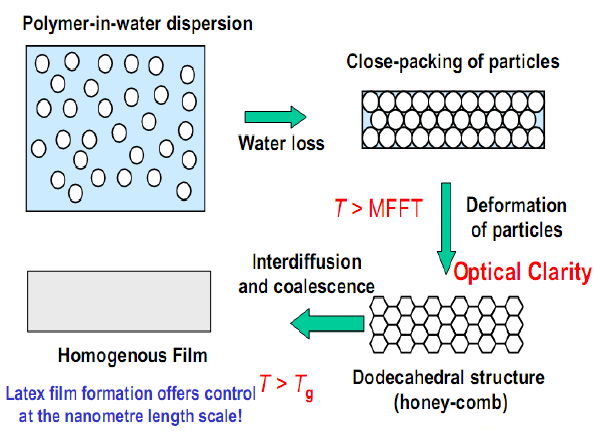
Fig. 5. Film formation from polymer latex